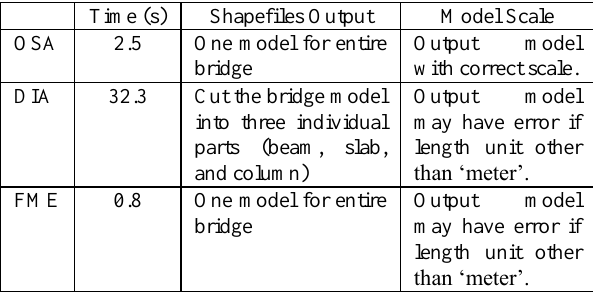
Table 2. Comparison conversion approach using OSA, DIA and